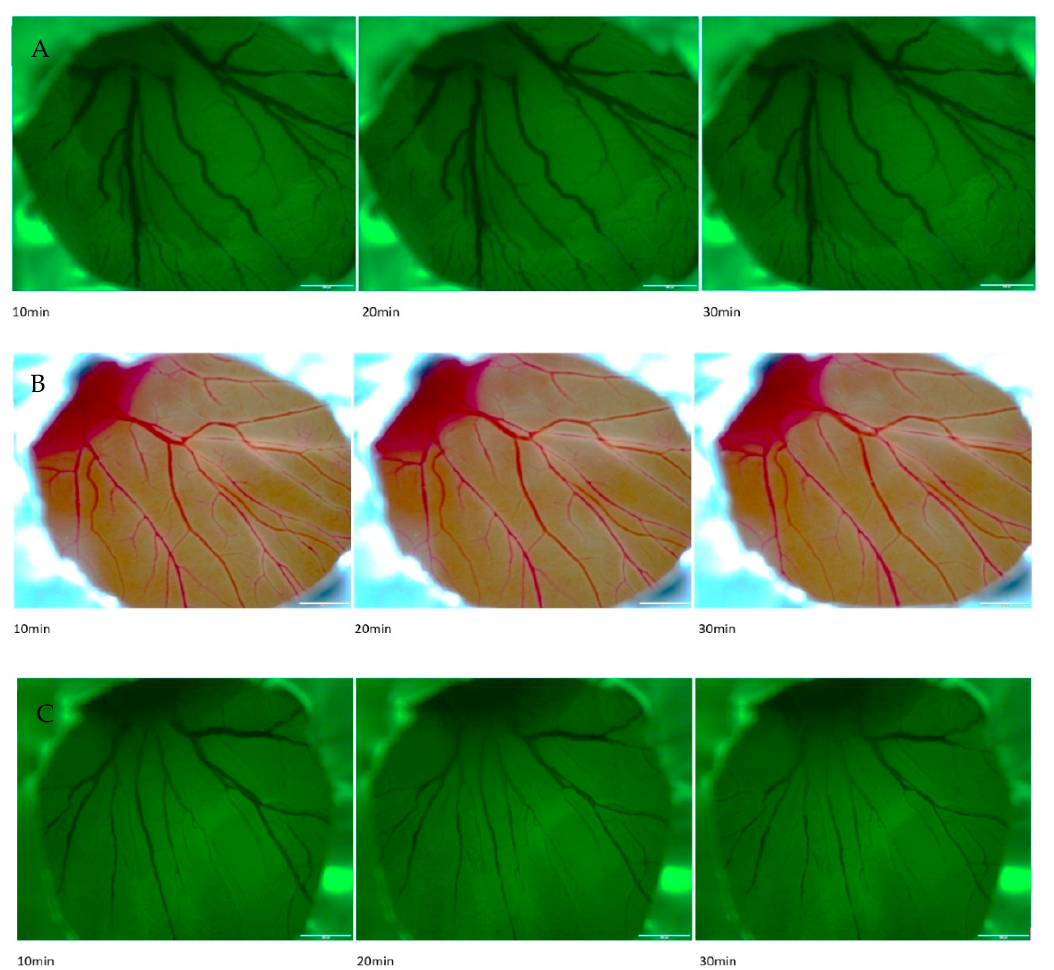
Figure 1. Effects of Rose Bengal in 5-day-old chicken embryos. Representative images of ( A ) injection of 3 µ L of PBS (negative control) and illumination for 30 min with 120 W 525/50 green cold light, ( B ) injection of 3 µ L of a solution of Rose Bengal of 50 mg/mL concentration without illumination for 30 min with 120 W 525/50 green cold light and ( C ) injection of 3 µ L Rose Bengal with illumination with 120 W 525/50 green cold